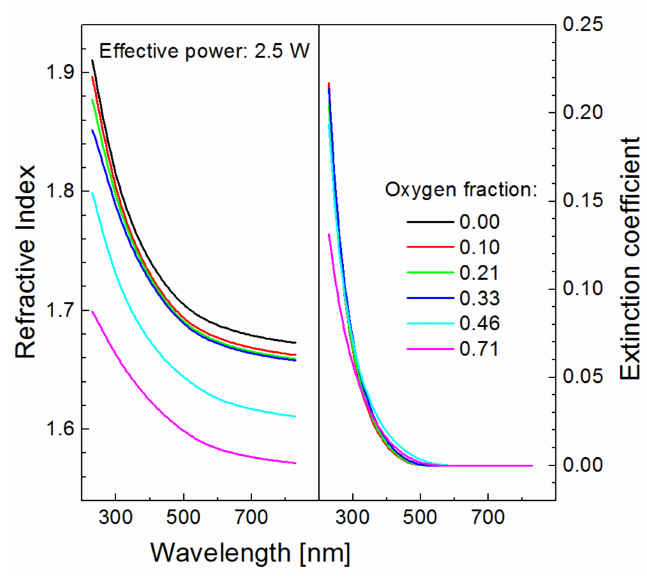
Figure 6. Optical properties (refractive index, extinction coefficient) of oxidized plasma polymer films deposited at an effective power of 2.5 W but various oxygen